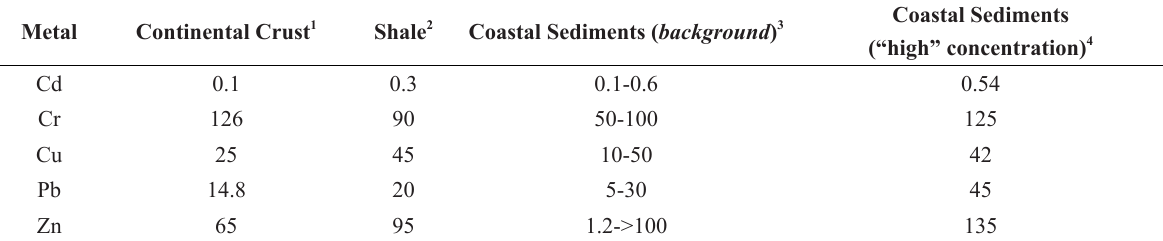
Concentration in μ g/g of some metals in continental crust, shale and coastal